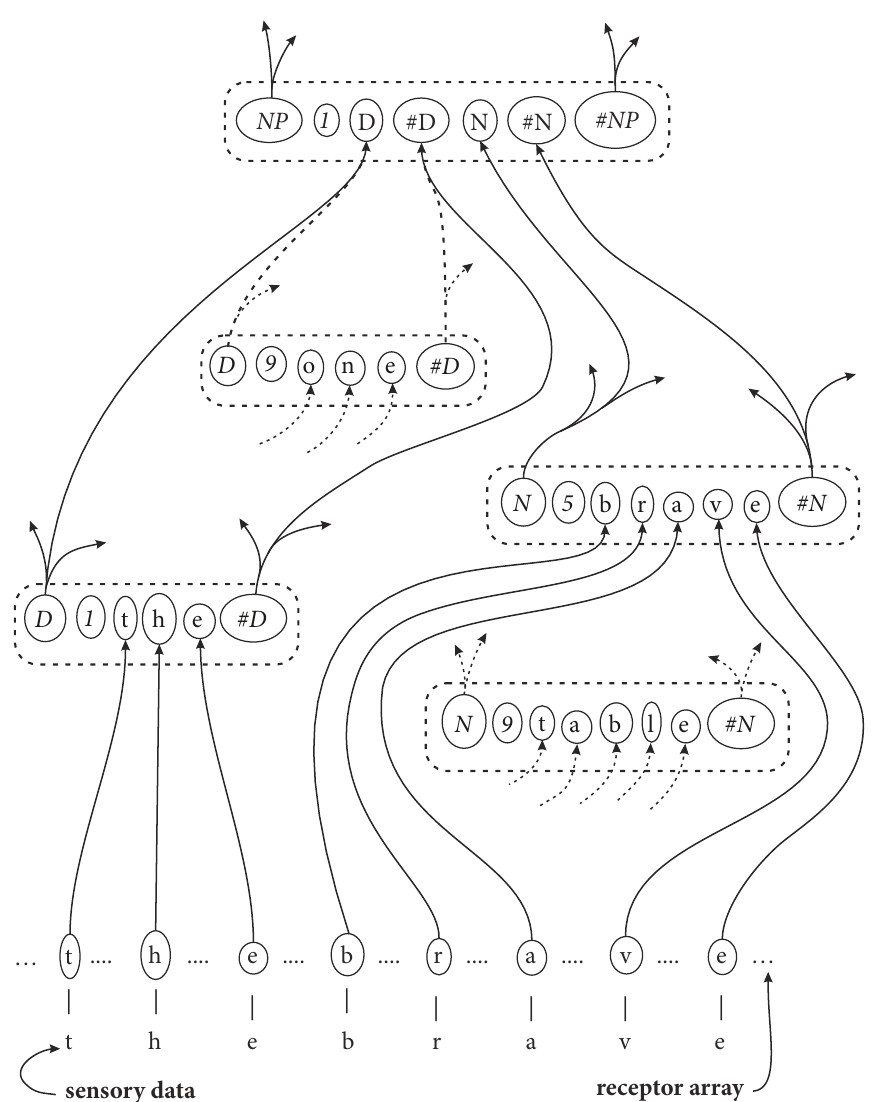
Figure 5: A schematic representation of a partial SP-multiple-alignment in SP-Neural, as discussed in [8, Section 4]. Each broken-line rectangle with rounded corners represents a pattern assembly —corresponding to an SP-pattern in the SP Theory. Each character or group of characters enclosed in a solid-line ellipse represents a neural symbol corresponding to an SP-symbol in the SP Theory. The lines between pattern assemblies represent nerve fibres with arrows showing the direction in which impulses travel. Neural symbols are mainly symbols from linguistics suchas “ NP ” meaning “noun phrase”,“ D ” meaning a “determiner”,“ #D ” meaning the end of a determiner,and “ #NP ” meaning the end of a noun phrase. Reproduced with permission from Figure 3 in